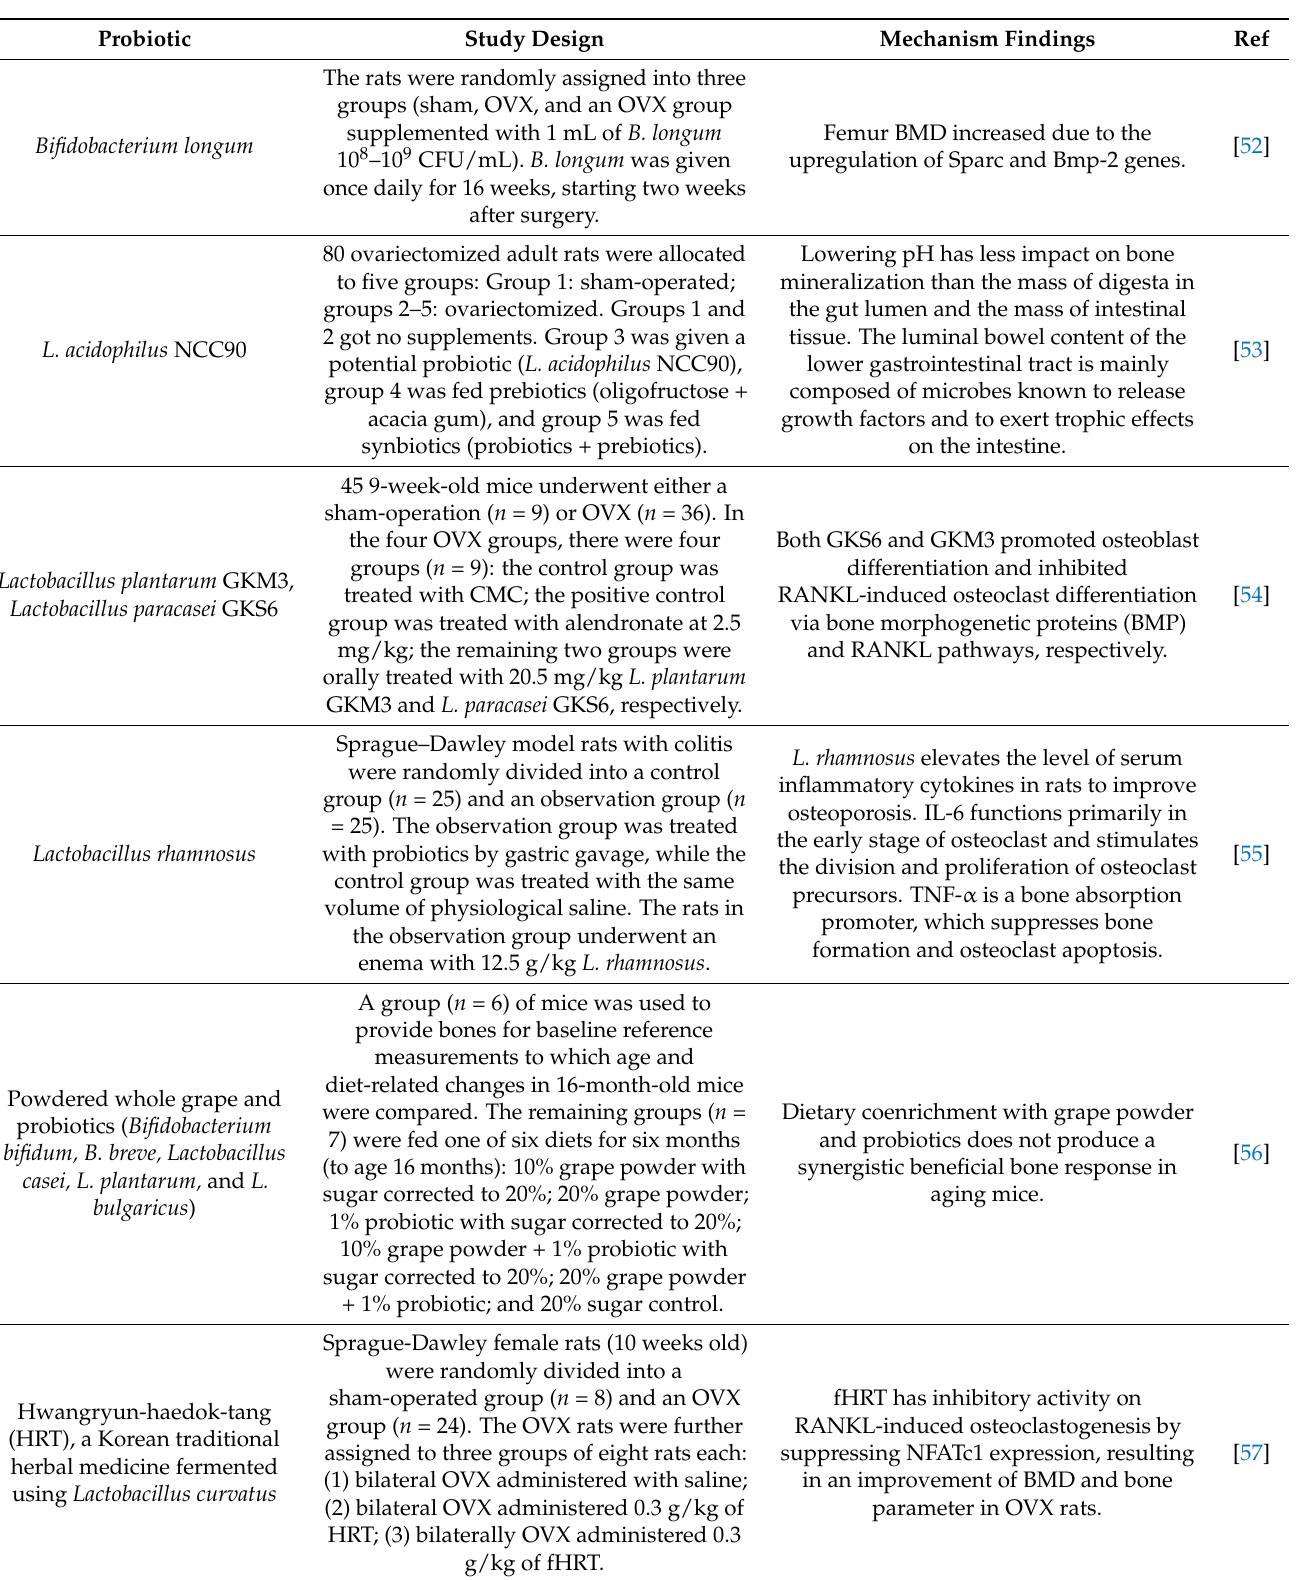
Table 4. Summary of animal